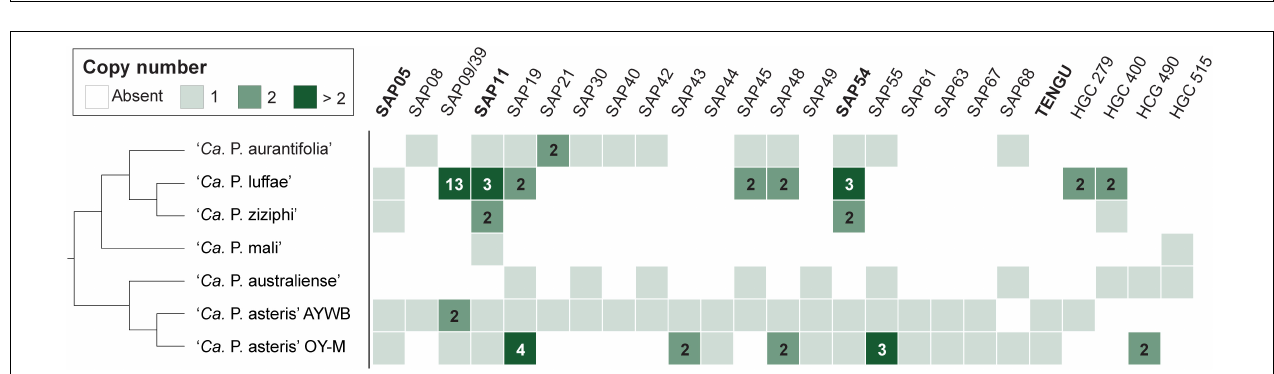
FIGURE 6 | Gene organization of PMUs. One representative PMU was selected from each genome for visualization, the chromosomal locations are labeled below the Candidatus species names. PMU-associated genes are color-coded according to annotation. Additionally, putative effector genes are colored in red. Intact genes are drawn with solid borders, putative pseudogenes are drawn with dotted borders.